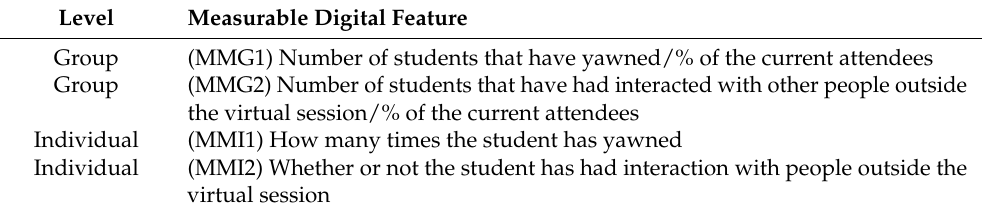
Table 15. Set of digital features defined for “mouth-movement analysis” category, corresponding to features B10, E2 and